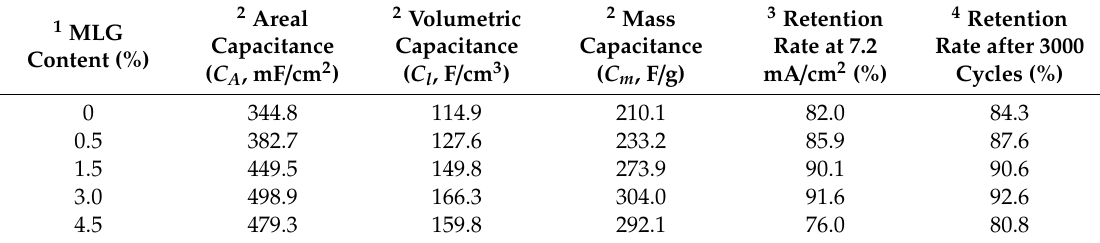
Table 5. Supercapacitor performances based on PVA–PANI–MLG HDGs with di ff erent MLG